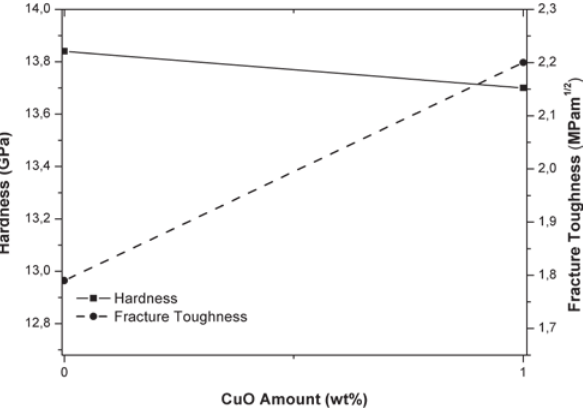
Fig. 2: The effect of addition of CuO on hardness and fracture toughness of 8YSZ.